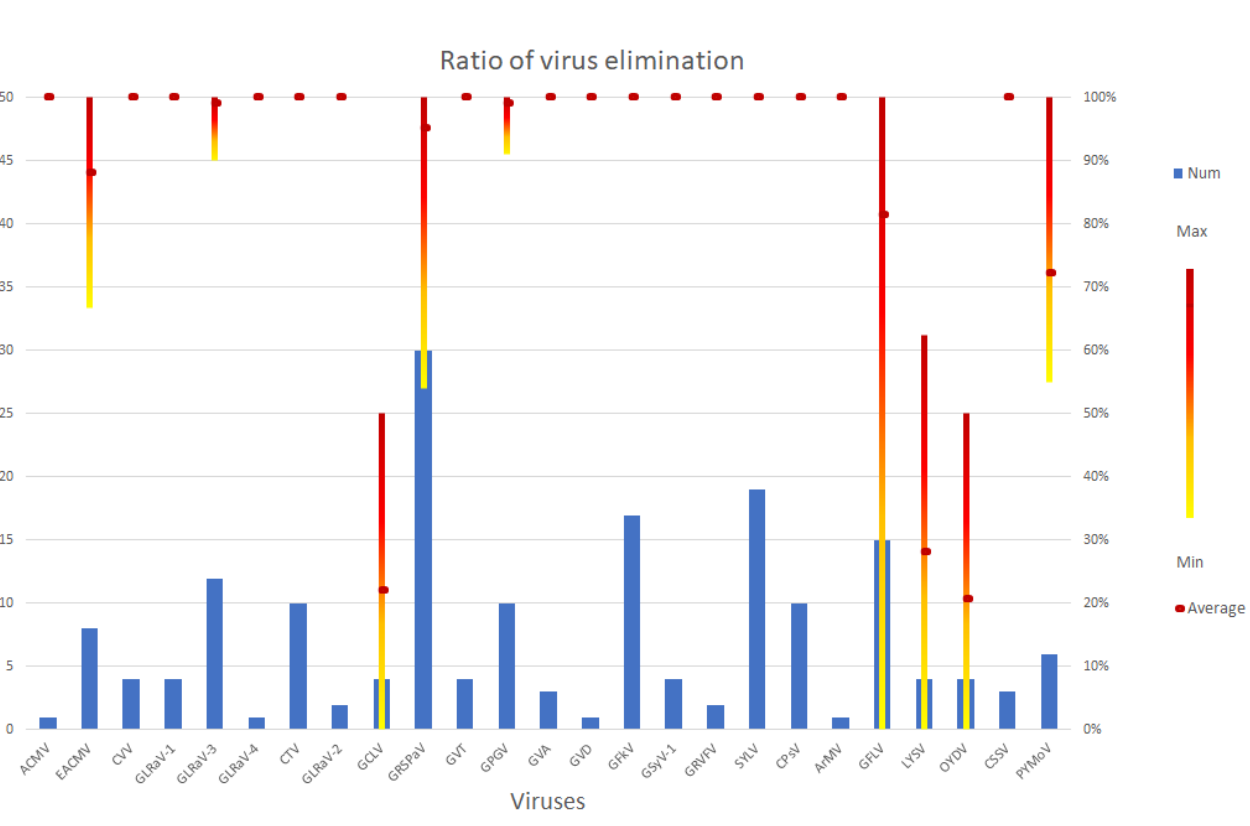
Figure 3. Elimination efficiencies of different viruses sorted by ICTV taxonomy. Blue bars show the number of available data for the different viruses.